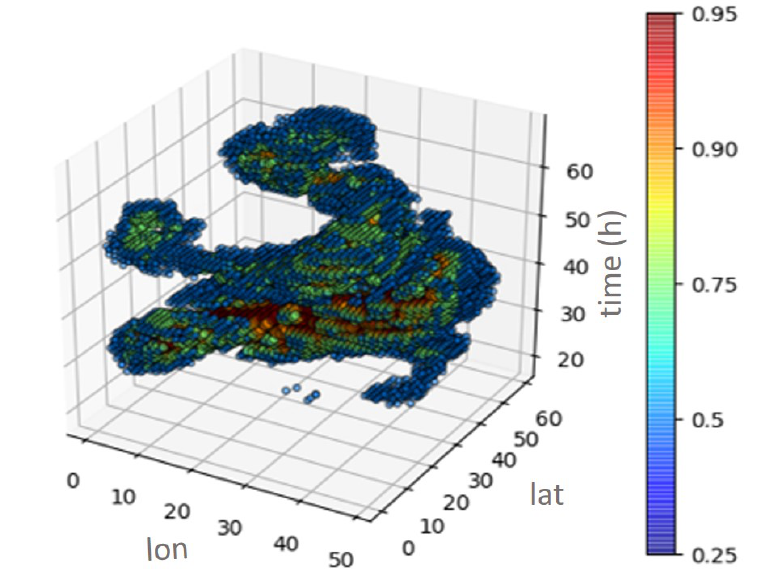
Figure 3. Multivariable kernel density of a storm object in space and time. Example for the storm event